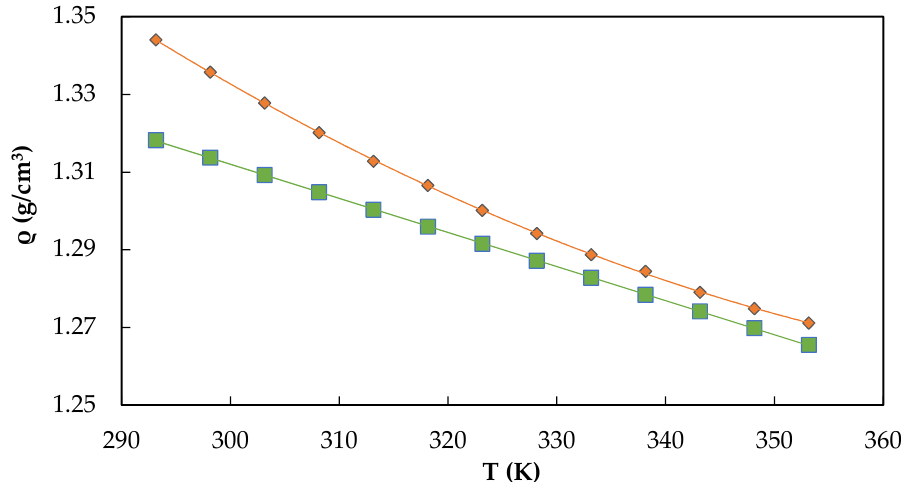
Figure 1. Temperature dependence of density ( ρ , g.cm − 3 ) for [C 2 mim][CF 3 BF 3 ] ( ) and [C 2 mim][CF 3 SO 2 C(CN) 2 ] ( ). The errors bars are smaller than the symbols used to represent the experimental data.